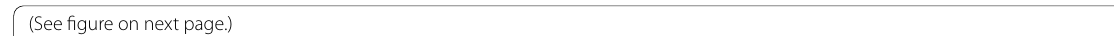
file 2: Figure S1a and Additional file 1: Table S2). Among the proteins encoded by 37 DEGs, 27 were assigned to the PHI database, with an e-value < 1E-5 cut-off. Of these proteins, 7 belonged to the loss of pathogenicity category, and 16 and 1 were associated with reduced virulence and increased virulence, respectively (Additional file 2: Figure S1b and Additional file 1: Table S3). Twenty-two proteins were mapped to an interaction network with a medium confidence score of 0.4 and were shown to cluster into three groups via the Markov cluster (MCL) algorithm (Additional